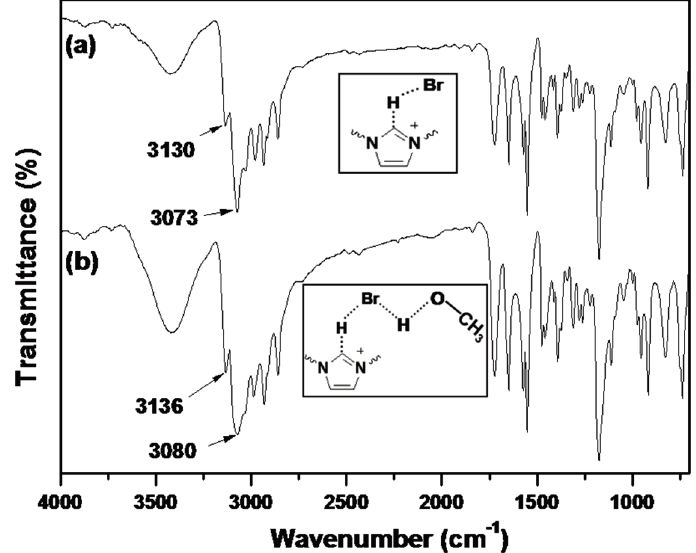
Figure 8. FTIR spectra of poly(EGDMA-co-[C 6 VIm]Br). (( a ) dried sample; and ( b ) the sample containing